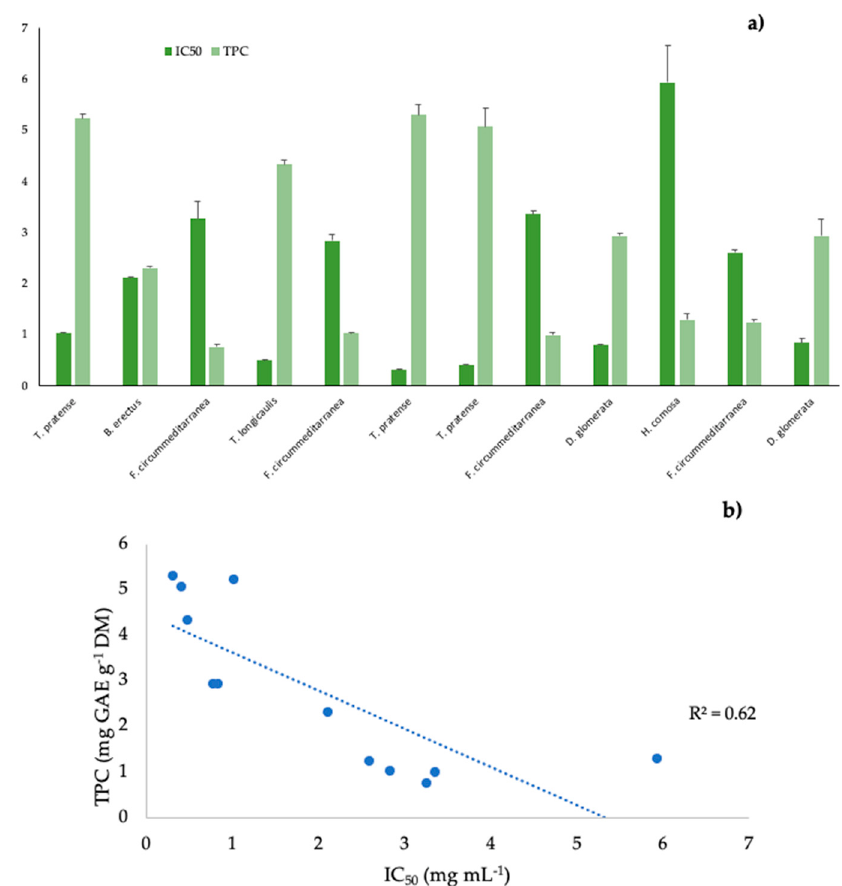
Figure 2. ( a ) Comparison between total polyphenol content (mg GAE g − 1 DM) and antioxidant activity (IC 50 mg mL − 1 ) of some of the investigated wild edible plants, collected during the third sampling (November–December). Plant species reported more than once were collected from different sites, specifically Monteforte, Verrino, Guardata and Guado Cannavina. The Y axis represents the antioxidant activity and total polyphenol content of the affected plants in the graph. ( b ) Correlation between antioxidant activities and total polyphenols content in